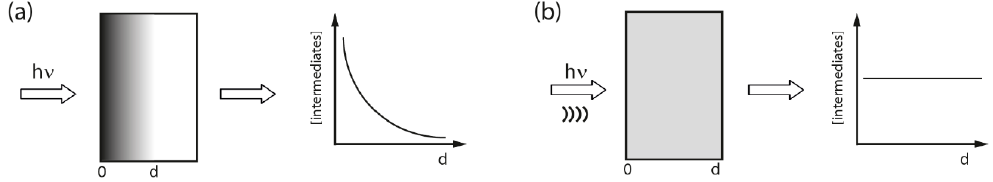
Figure 3. Distribution of excited states in the photochemical process ( a ) and after addition of sonication, ( b ). (Dots represent the density of activated species). Adapted from [24] with permission from Elsevier.